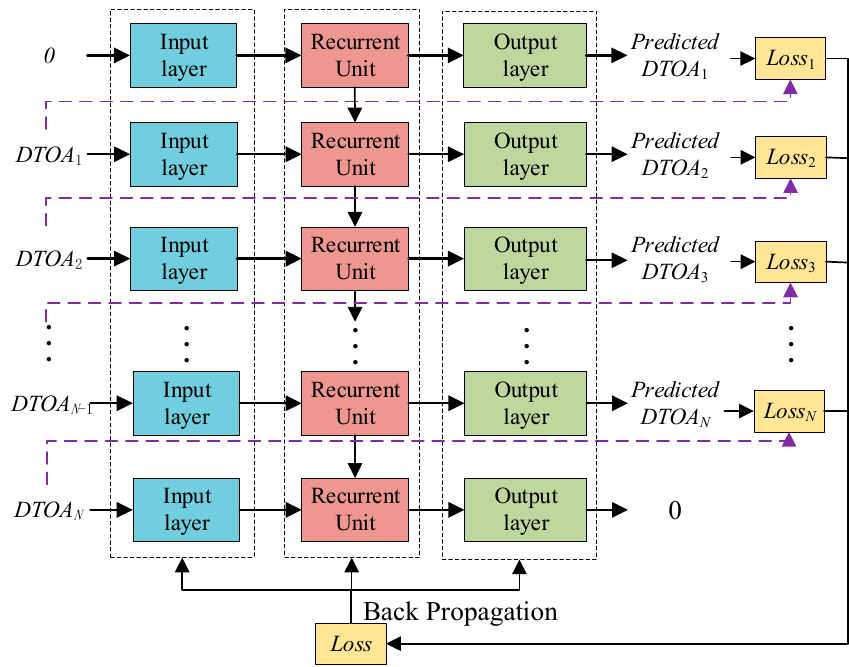
Figure 3. Unfolded diagram of self-supervised learning RNN.